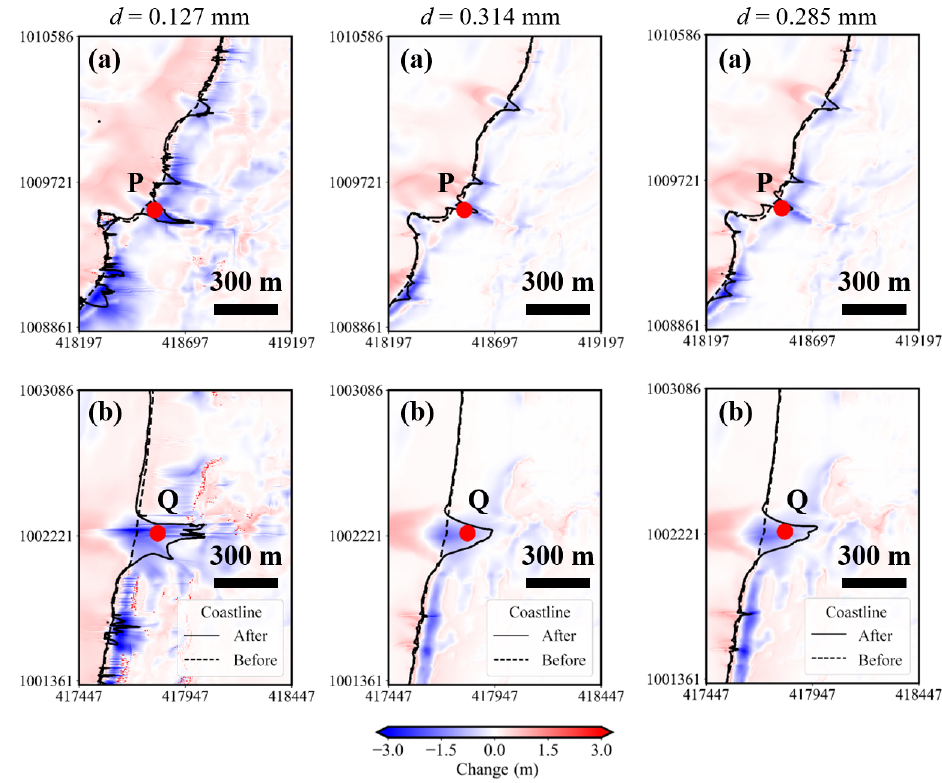
Figure 9. Topographic change and shoreline position caused by the tsunami for each grain